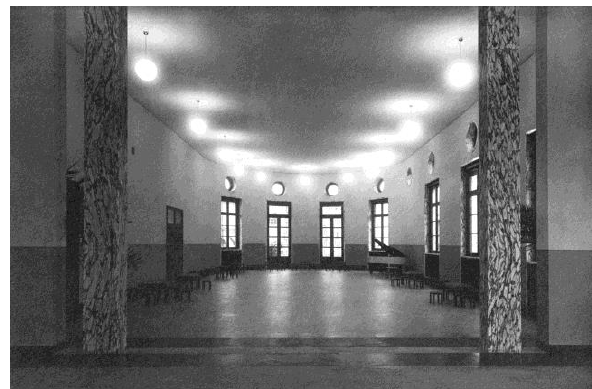
Figure 5. Santarelli Kindergarten, internal view of the period. ©